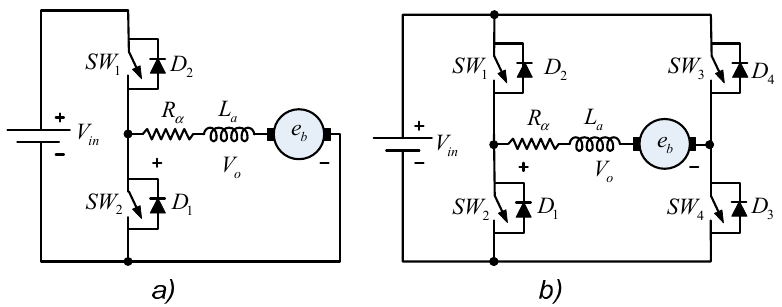
Figure 12. ( a ) Two-quadrant and ( b ) Four-quadrant hard-switching DC motor drives . Depending on whether the zero output voltage loops are employed or not, using the above control methods, the converter’s output voltage can be either bipolar or multilevel. In the case of a